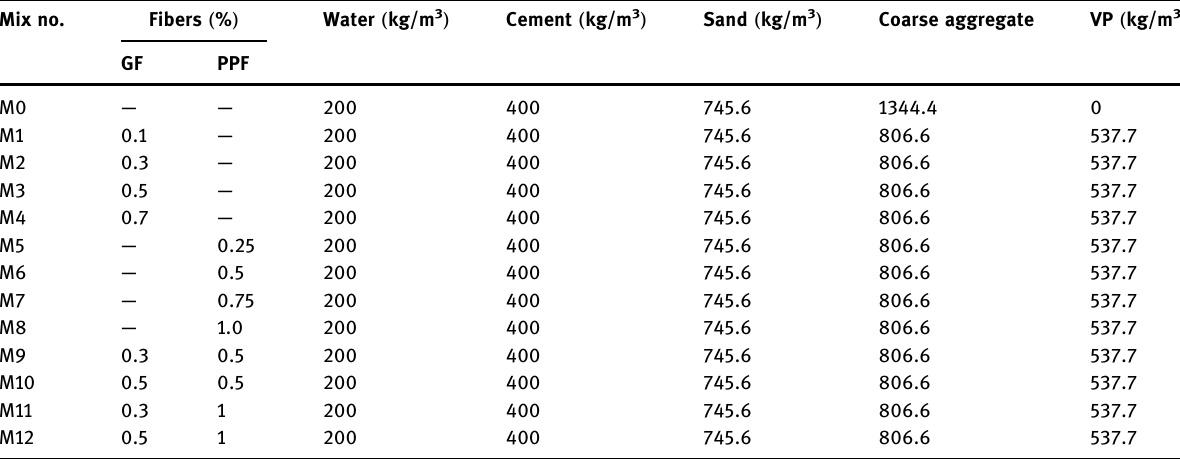
Table 9: Mix Proportion of reference concrete and LWC mixes Mix